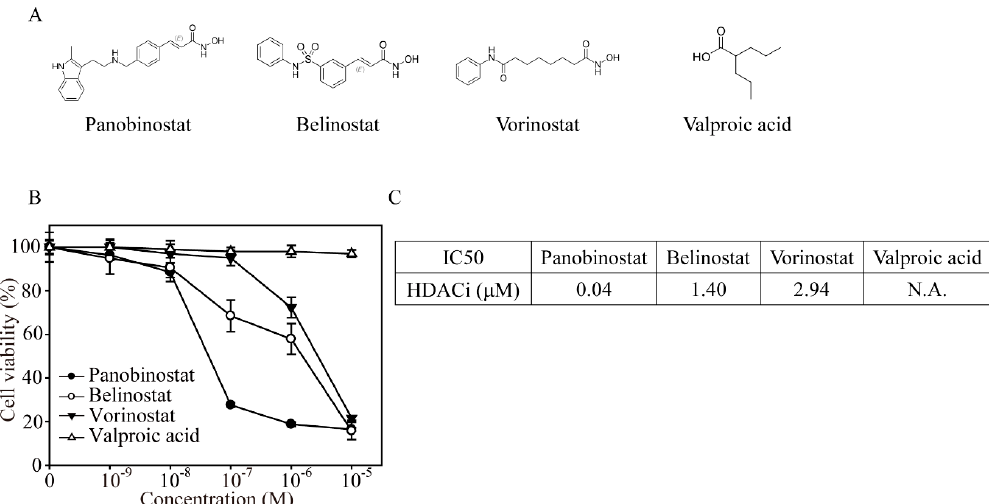
Figure 1. Food and Drug Administration (FDA)-approved HDACis significantly suppressed K562 cell viability in a dose-dependent manner. ( A ) Chemical structures of panobinostat, belinostat, vorinostat and valproic acid. ( B ) MTT cell viability after four HDACi (0.001, 0.01, 0.1, 1 and 10 μ M) treatments on K562 cells for 24 h. The values are presented as the means and standard errors. The experiment was performed at least in triplicate. ( C ) The IC50 of HDACi is the drug concentration that induced a 50% inhibition of cell viability.